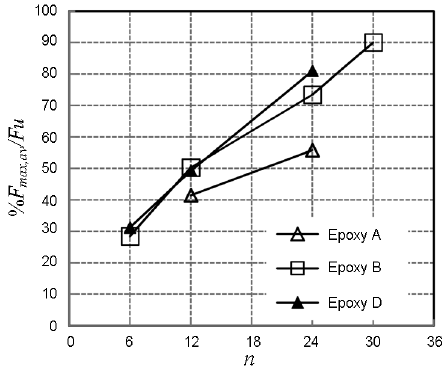
Fig. 14. Effect of epoxy type and bond length for specimens with GFRP bars on %F max,av /F u ; ( n = L b / d b )